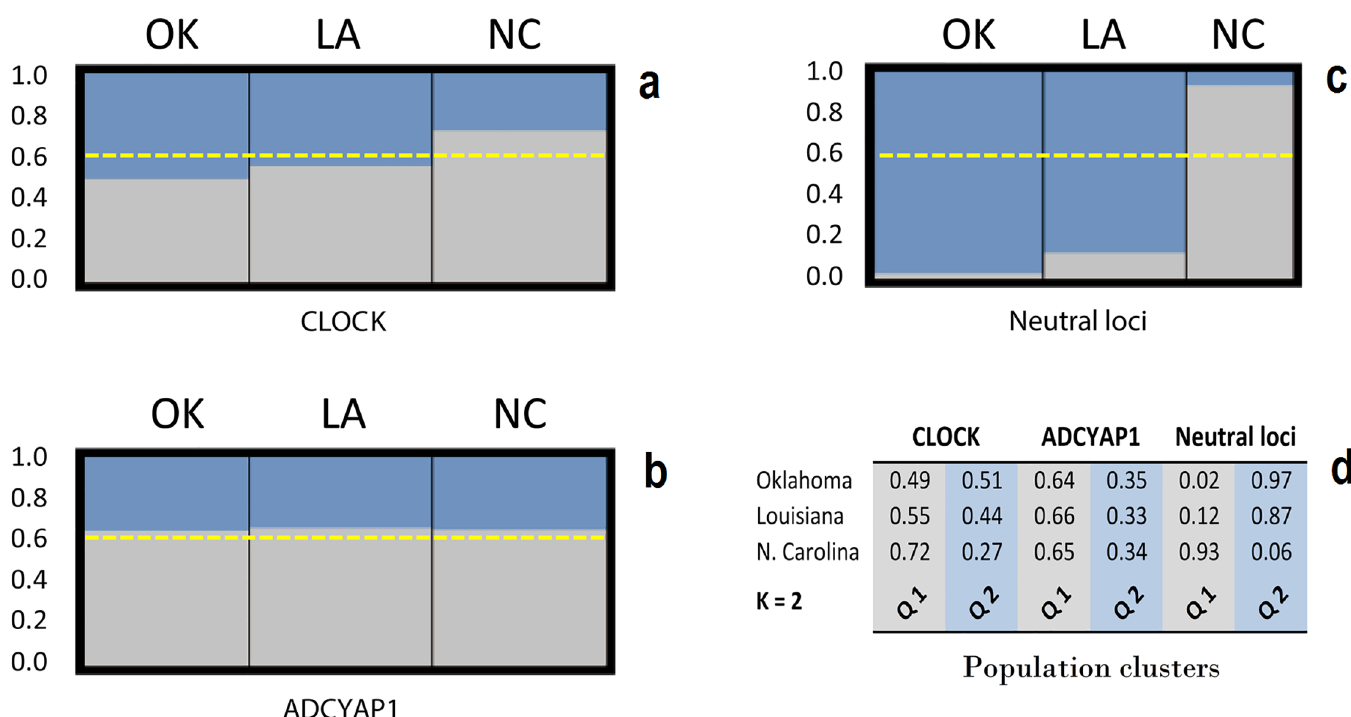
Fig 2. STRUCTURE Q matrix output for Clock , Adcyap1 , and neutral loci. The graphs show the cluster assignment probabilities for Painted Buntings sampled in three populations (OK = Oklahoma; LA = Louisiana; NC = North Carolina) for K = 2. The probability (Q) of each population to be assigned to a cluster is shown on the vertical axes and in panel d. Each cluster is represented with a different color. The dashed yellow line represents the threshold probability (Q > 0.6) above which a population is considered part of a distinct cluster.